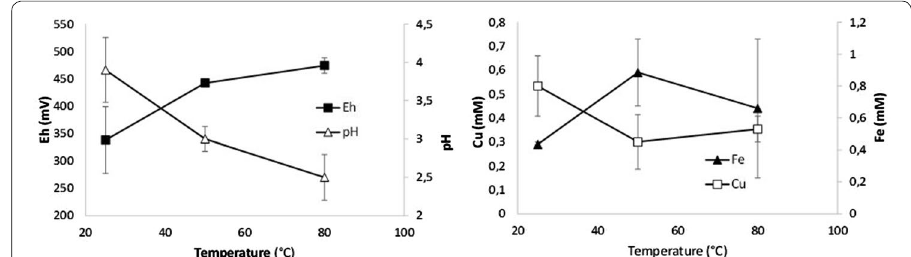
Fig. 8 Experimental data (A, B, C): effect of temperature on pH, Eh ( left ) as well as on Cu- and Fe concentra- tion ( right